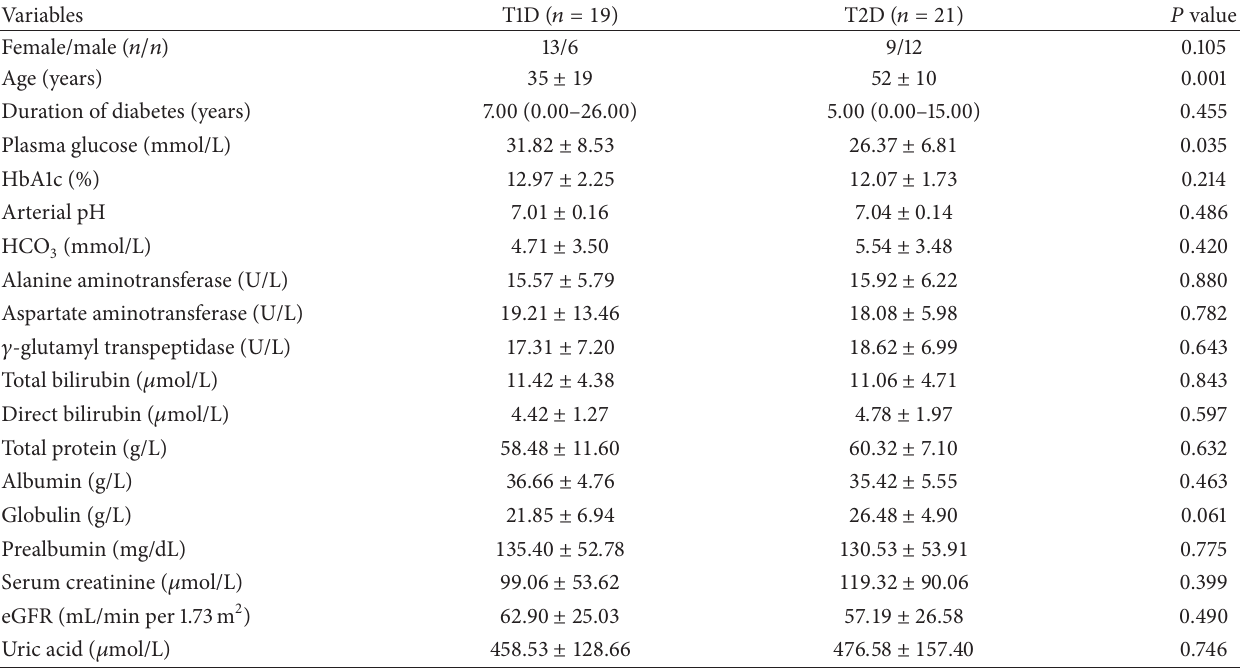
Table 2: Clinical and biochemical characteristics of the T1D and T2D patients with DKA at admission. Variables